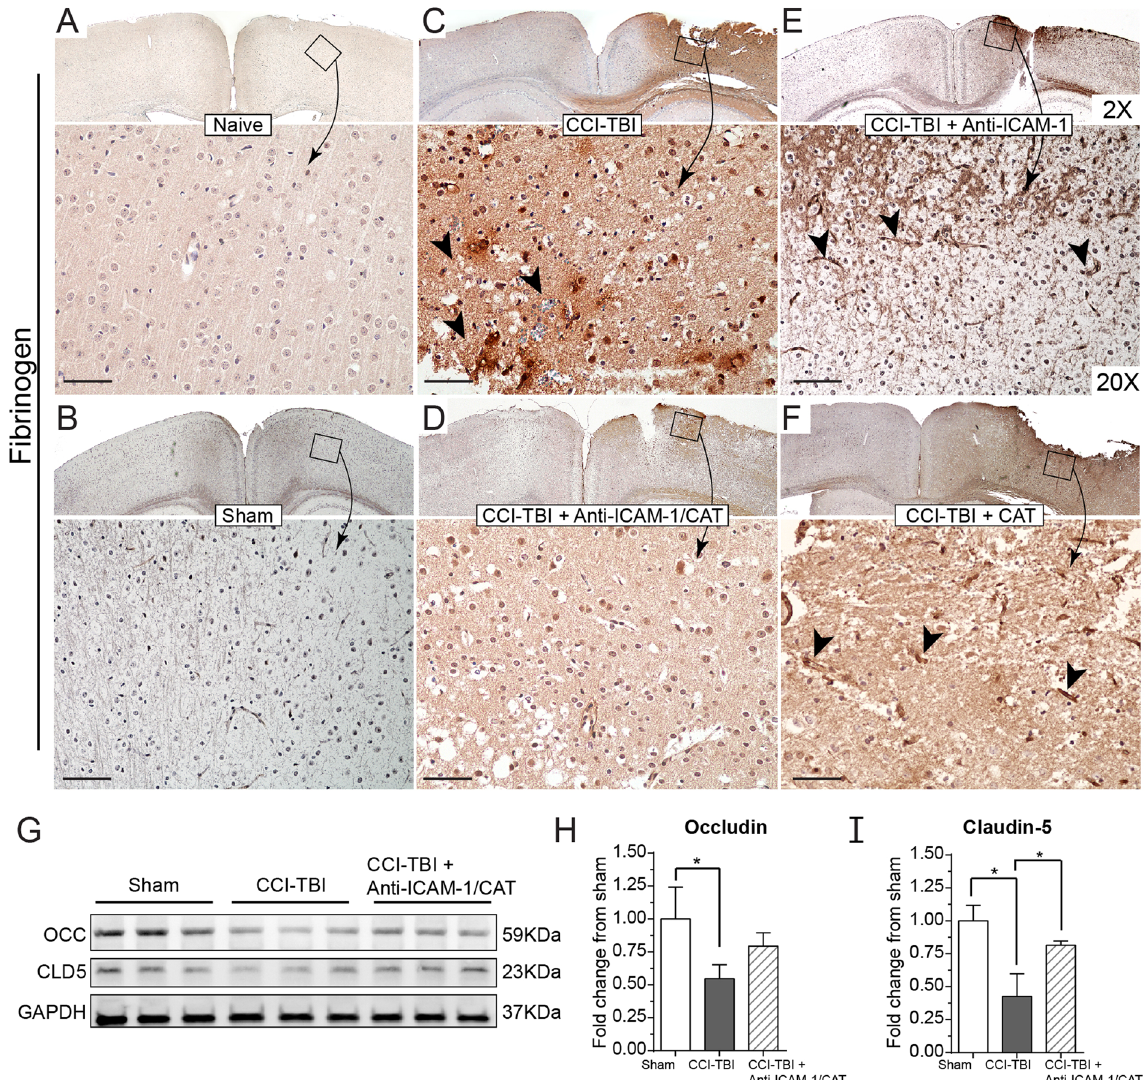
Figure 4. CCI-TBI increases BBB permeability to fibrinogen and decreases tight junction protein detection with a rescue or preservation of barrier function with anti-ICAM-1/catalase. Immunohistochemical detection of plasma protein fibrinogen in brain parenchyma at 48 hr following moderate CCI-TBI. ( A,B ) Naive and sham controls show absent fibrinogen detection in the brain parenchyma, as the BBB is healthy and intact. Absence of staining maintained at 20X. ( C ) Following CCI-TBI, BBB hyperpermeability permits the extravasation of fibrinogen into the brain tissue. Black arrowheads indicate areas of dense fibrinogen staining in the perivascular space. ( D ) Anti-ICAM-1/catalase reduces parenchymal and perivascular fibrinogen detection in the brain by 48 hrs post-CCI-TBI. ( E , F ) Anti-ICAM-1 antibody and catalase alone do not appear to reduce fibrinogen extravasation as indicated by intense fibrinogen detection in the impact site with dense staining in perivascular space. Scale bar equals 50 microns. (Top panels 2X, bottom panels 20X). ( G ) Western blot analysis of tight junction protein expression for occludin and claudin-5 in the cortex ipsilateral to the site of CCI-TBI for sham, CCI-TBI and CCI-TBI + anti-ICAM-1/catalase groups. The whole membrane was cut at 75 kDa and between 37 and 25 kDa to minimize antibody use. Membranes were separately probed for occludin and claudin-5. The membrane probed for occludin was striped, reblocked, and then probed for GAPDH. Full length blots are presented in Supplementary Figure 1. ( H , I ) Densitometry quantification for occludin and claudin-5 normalized to GAPDH presented as mean ± SD (Ordinary one-way ANOVA with multiple comparisons occludin F = 5.779, P = 0.0399. Claudin-5 F = 17.42, P =